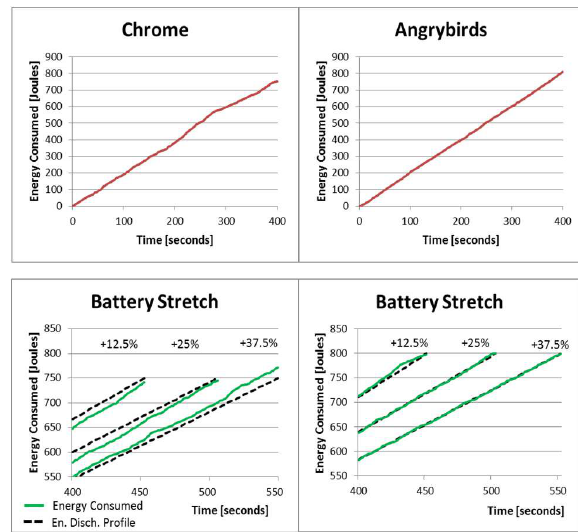
Figure 5. Standard energy consumption and battery stretch For the first experiment, we recorded two traces on the Nexus 5 from two popular Android applications: Chrome